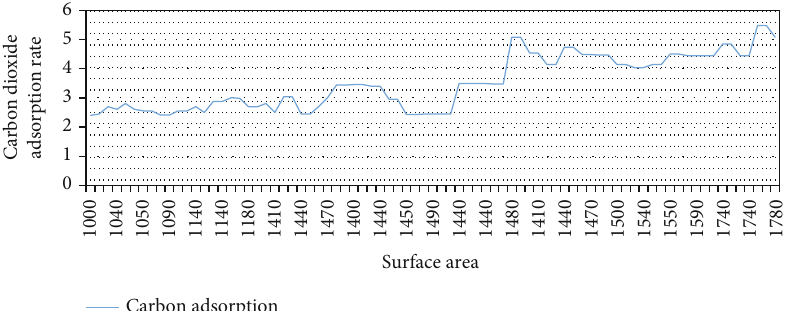
Figure 3: Representation of the data statistics for the input ( CO collected from the dataset in [7, 8]).